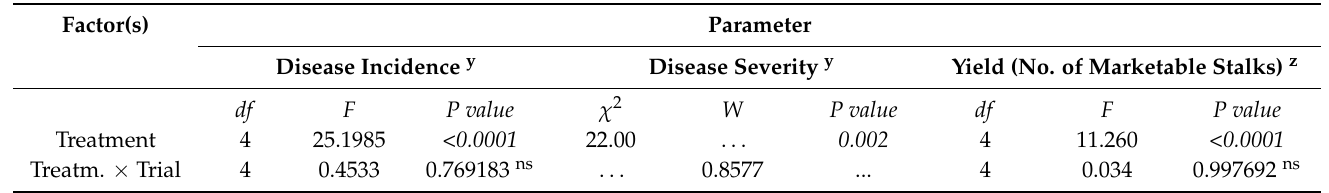
Table 3. Analysis of variance for disease incidence, severity (nonparametric approach) and n. of marketable chrysanthemum stalks among 5 soil treatments in two